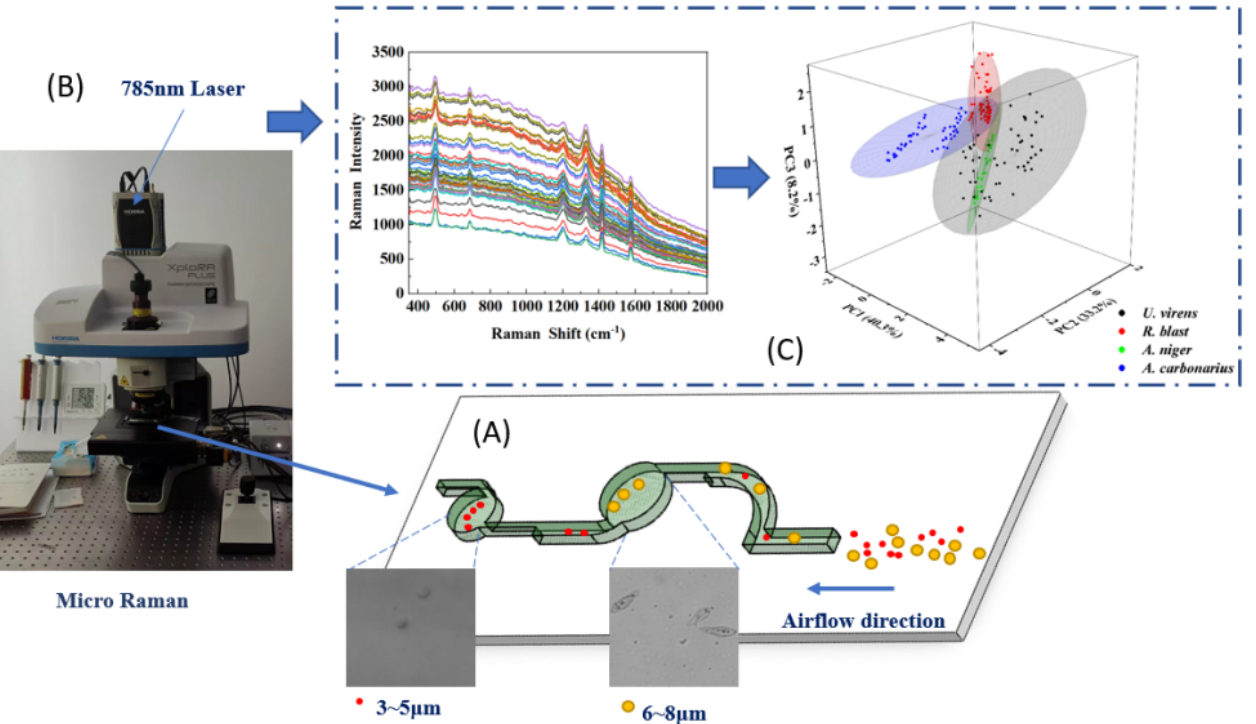
Figure 1. Detection of crop disease spores by microfluidic chip combined with micro Raman spec- troscopy: ( A ) spore capture, separation, and enrichment; ( B ) micro Raman collection; ( C ) Raman data processing and modeling.